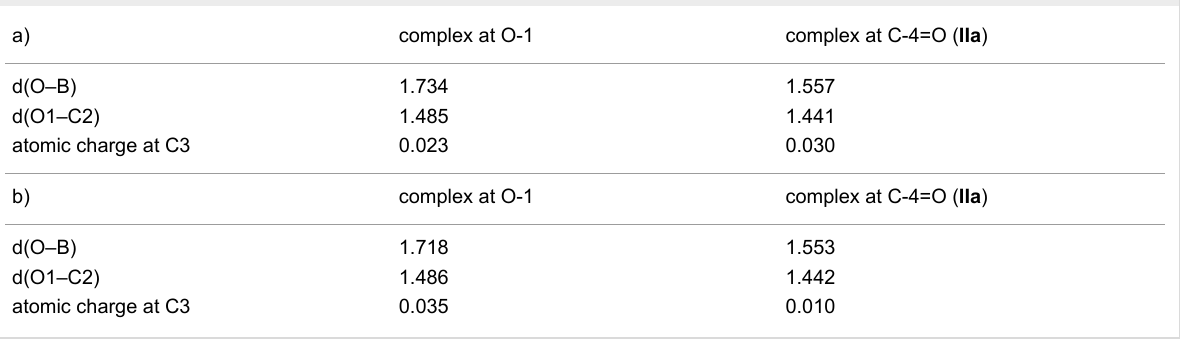
Table 4: Bond distance and atomic charge of interest in BF 3 -silybin A at C-4=O (complex IIa ) and O-1, in a) EtOAc and b) DMF.